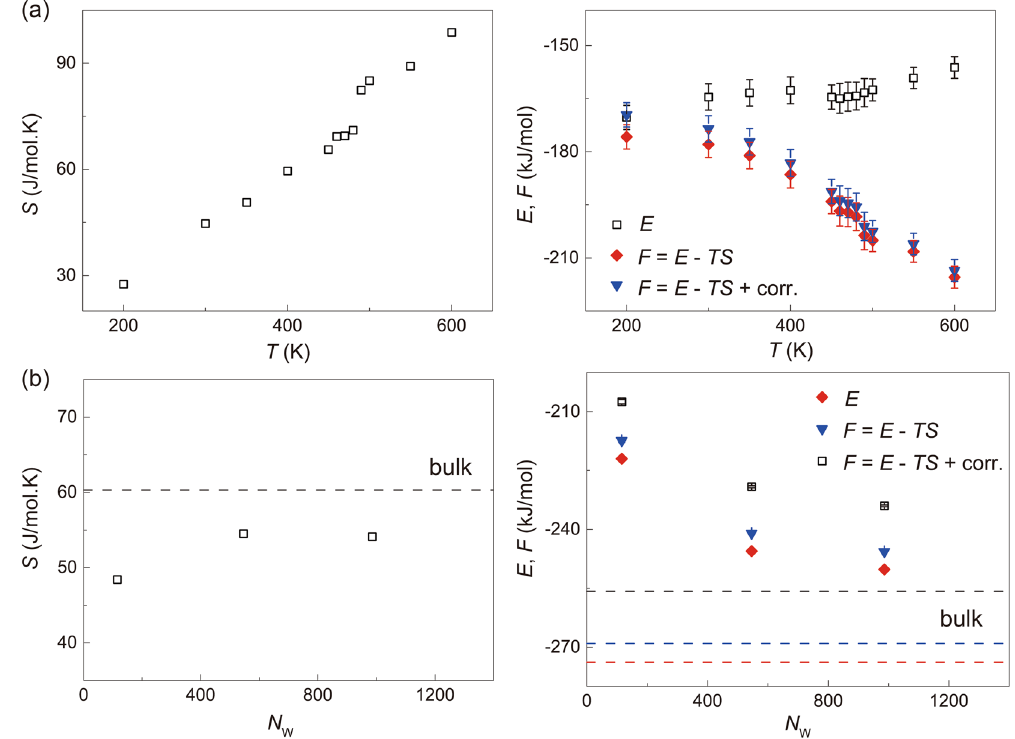
Figure 4. Entropy ( S ), total energy calculated from MD simulations ( E ), free energy ( F ) for the EW as temperature T = 200–600 K ( a ) and water number N W = 115, 546, 986 (mono-, bi-, tri-layer), as well as bulk water ( b ). The correction on free energy with ZPE and heat capacity terms are considered, using the 2PT model. The error bars measure the energy fluctuations in MD simulations.